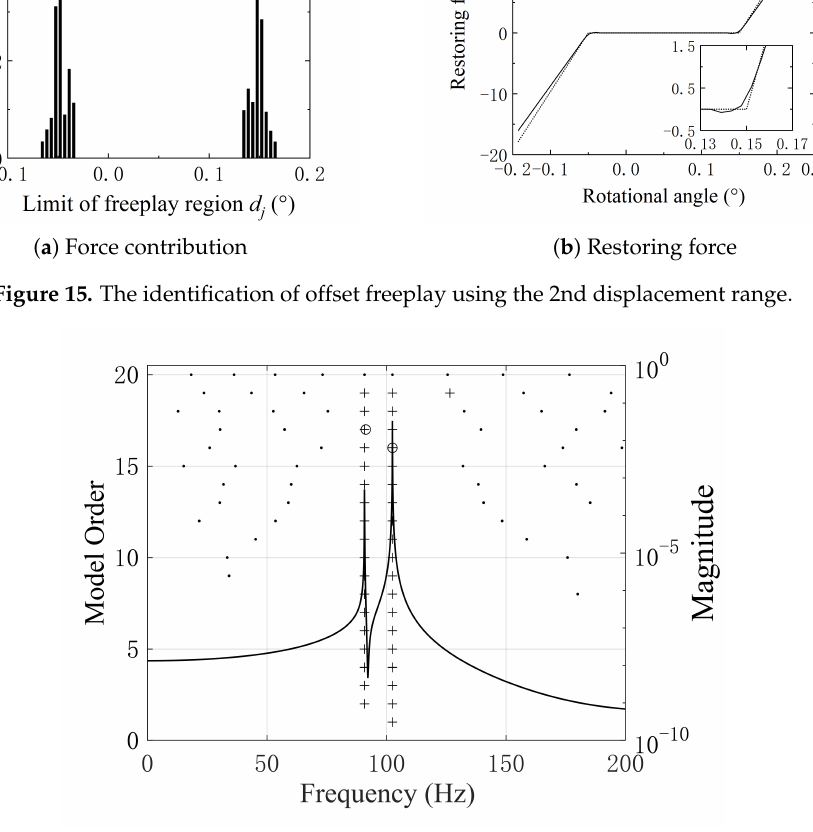
Figure 16. Stabilization diagram of OLS of offset freeplay computed by TNSI method using the estimated FRF( H 22 ). (Dot: Not stable in frequency; Circle: Stable in frequency; Cross: Stable in frequency and